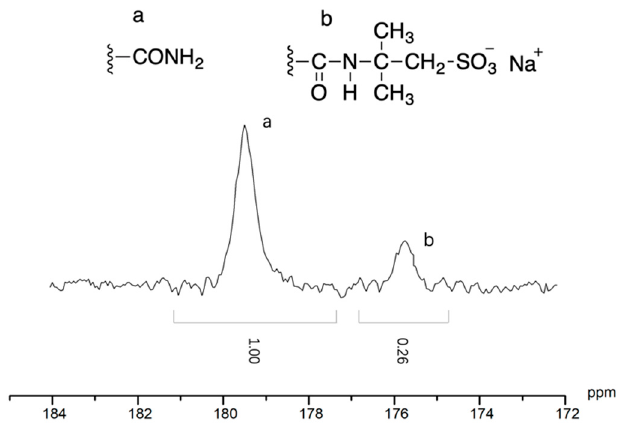
13 C NMR spectrum of the polymer S3. Figure 4.